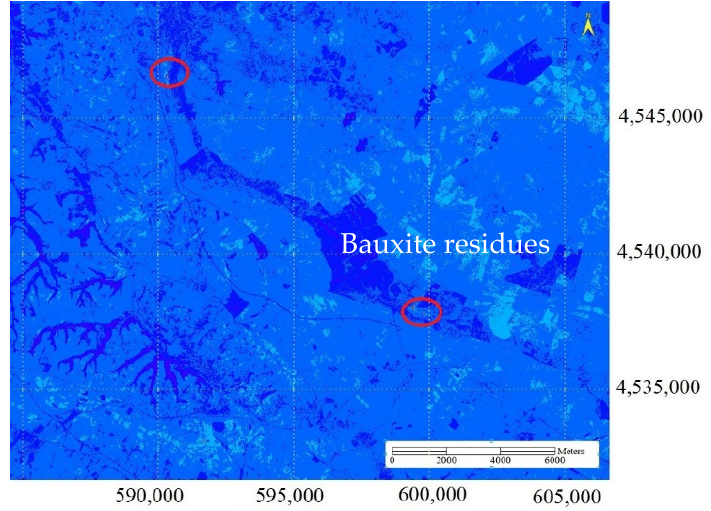
Figure 6. Band ratio analysis (iron oxides: Band28/Band8) detecting elements’ variety inside the bauxite residues (PRISMA).